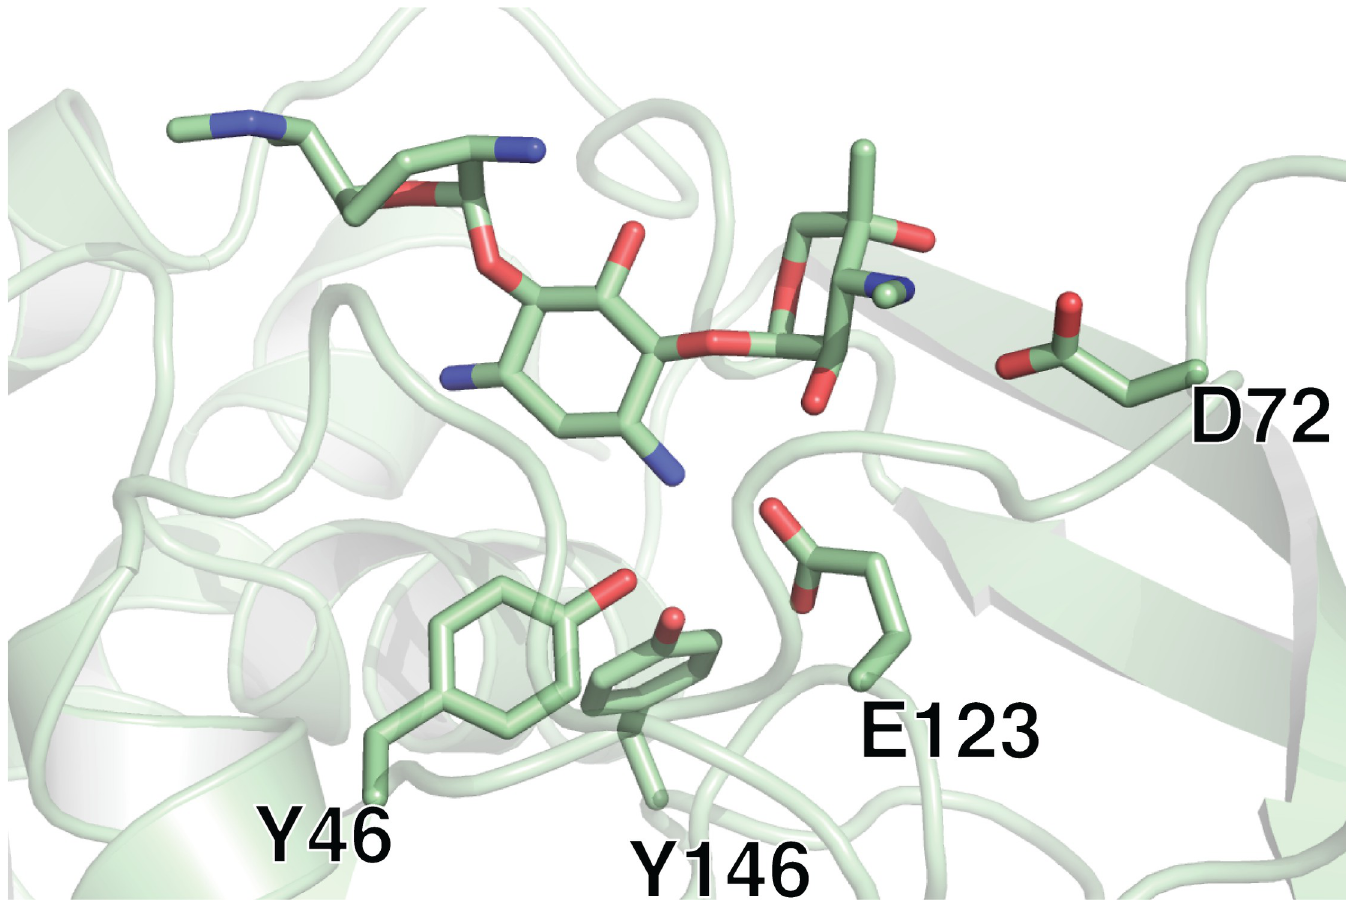
Fig 6. Residues implied in binding of gentamicin to the main aminoglycoside binding site.